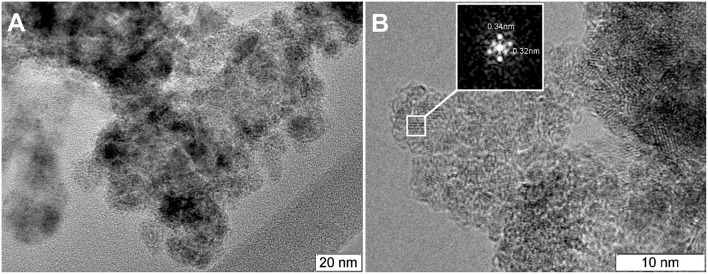
(A) TEM image of the Pt/Ce-600 sample, and (B) HRTEM and Fourier image of the CeO2 crystal lattice.